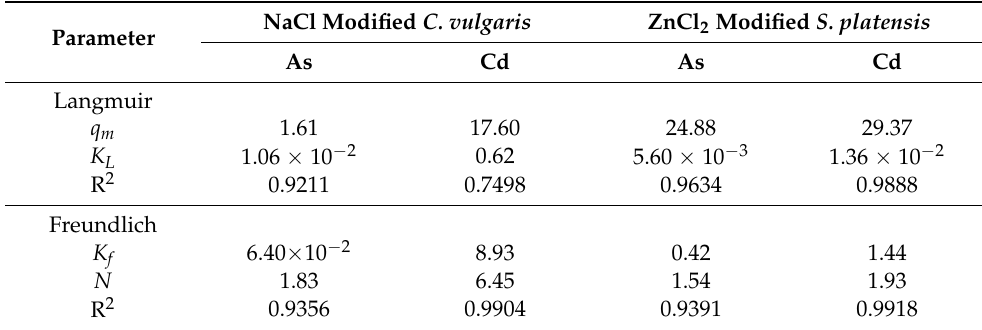
Table 2. Isotherm model parameters for As(V) and Cd(II) biosorption onto NaCl modified C. vulgaris and ZnCl 2 modified S. platensis